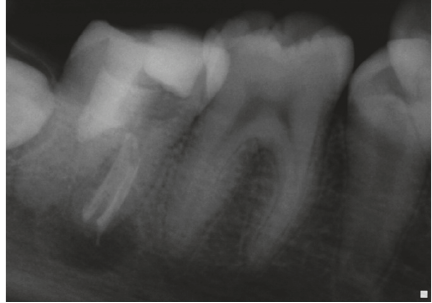
Figure 6: Filling of the mesial roots with MTA.